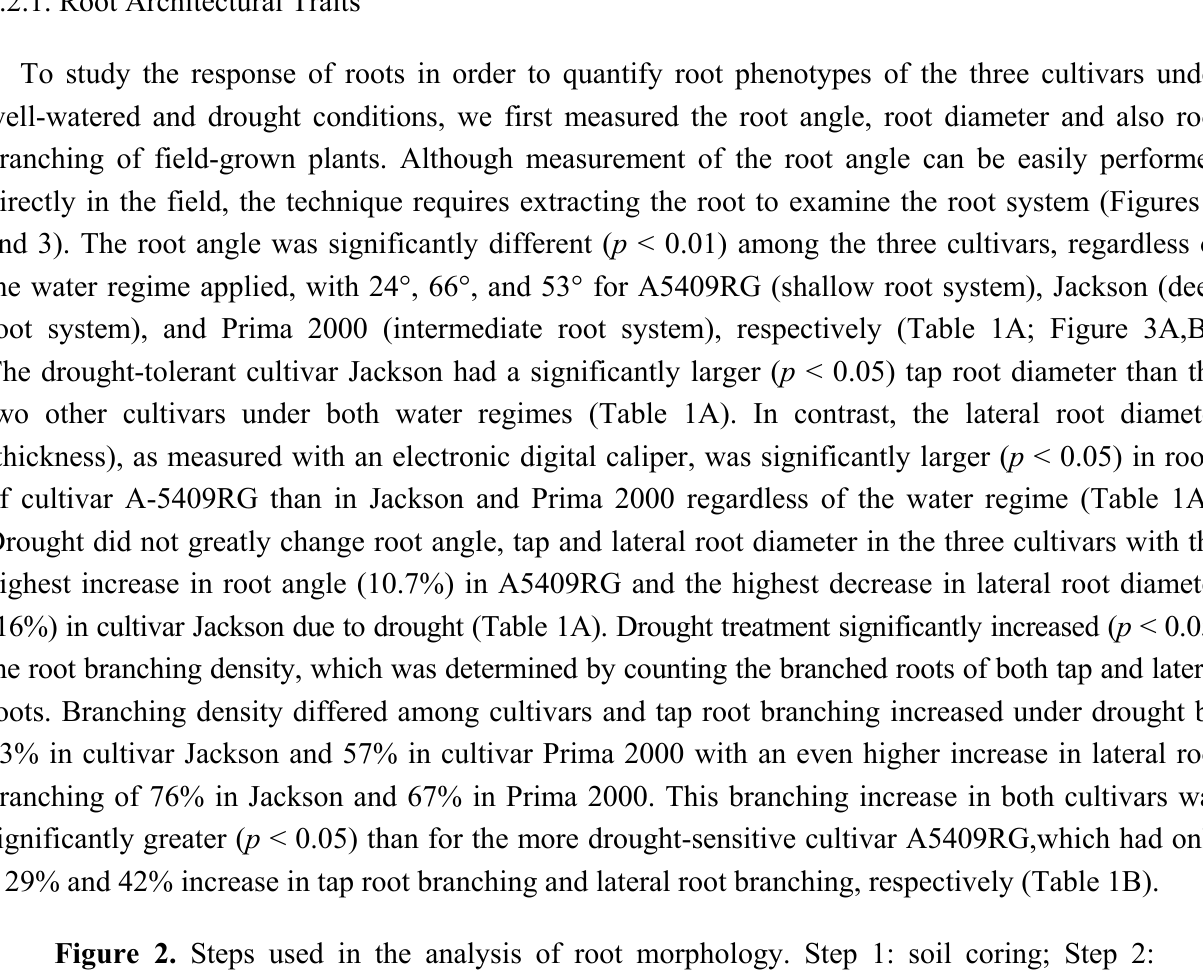
Figure 2. Steps used in the analysis of root morphology. Step 1: soil coring; Step 2: dividing soil samples; Step 3: washing of roots; Step 4: separating roots from soil; Step 5: preserving roots in 25% ethanol; Step 6: scanning roots using root scanner